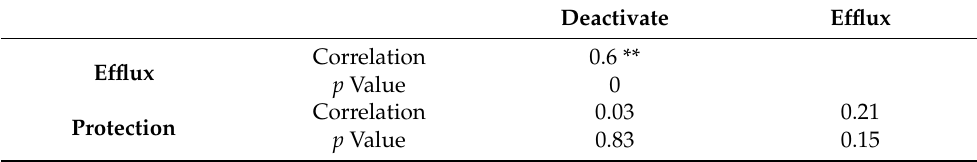
Table A6. Spearman (cid:48) s rank correlation coefficient and the significance between ARG